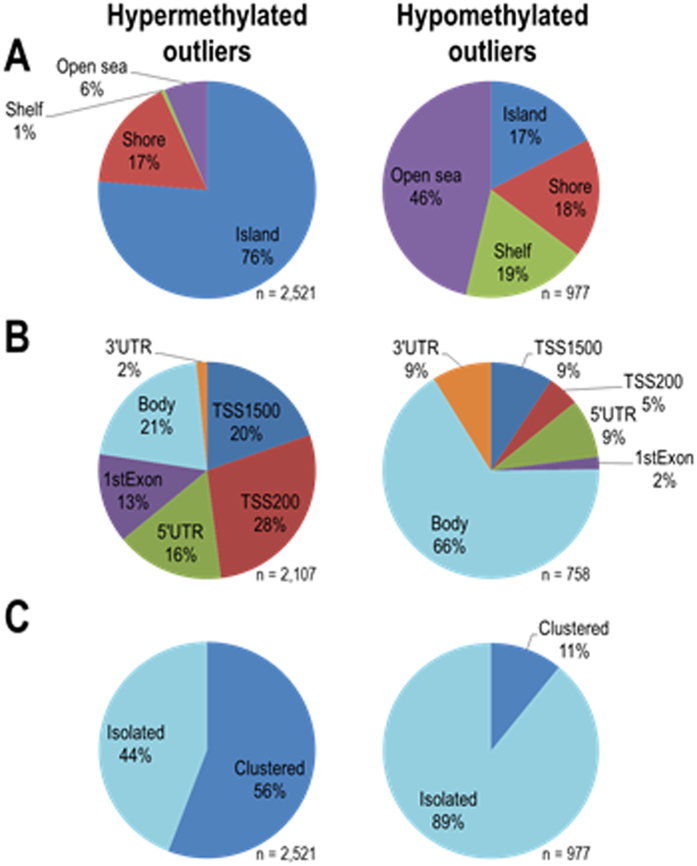
Genomic features of 2,521 hyper- and 977 hypomethylated outliers.Distribution of outliers in relation to CGIs and their shores and shelves (A) and to gene feature groups (B). Six gene feature categories, i.e., TSS1500, TSS200, the 5′UTR, the first exon, the gene body, and the 3′UTR, are regarded as genic regions, in which 2,107 (84%) and 758 (78%) CpG sites were located. The ratio of clustered and isolated outliers is shown (C).